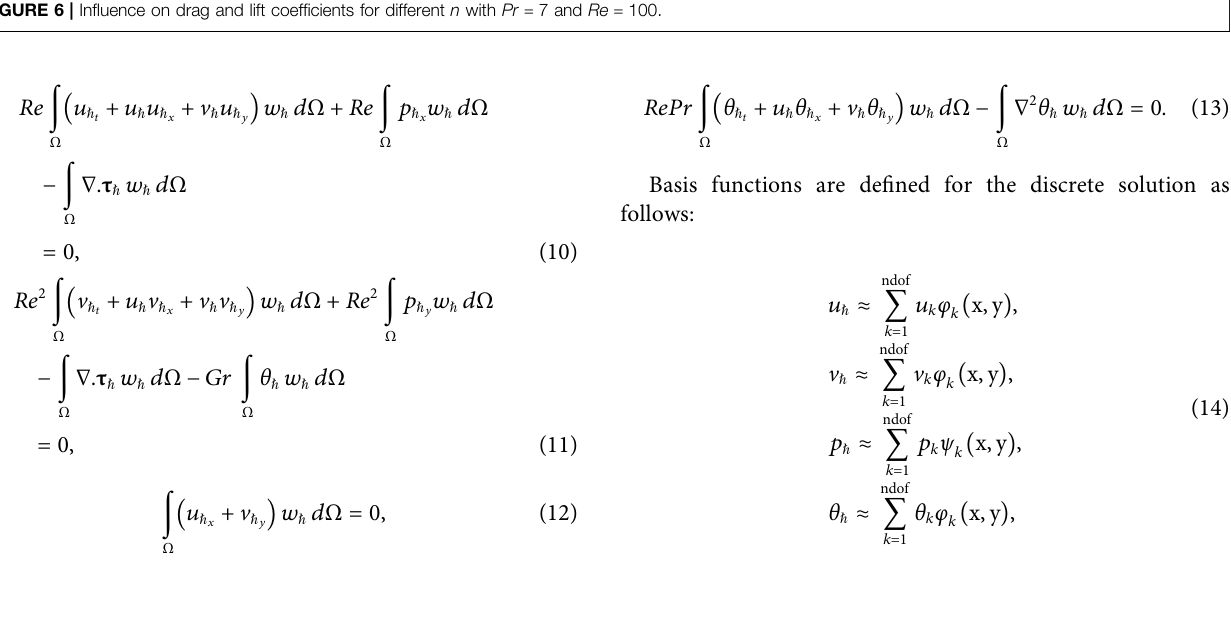
Frontiers in Physics |